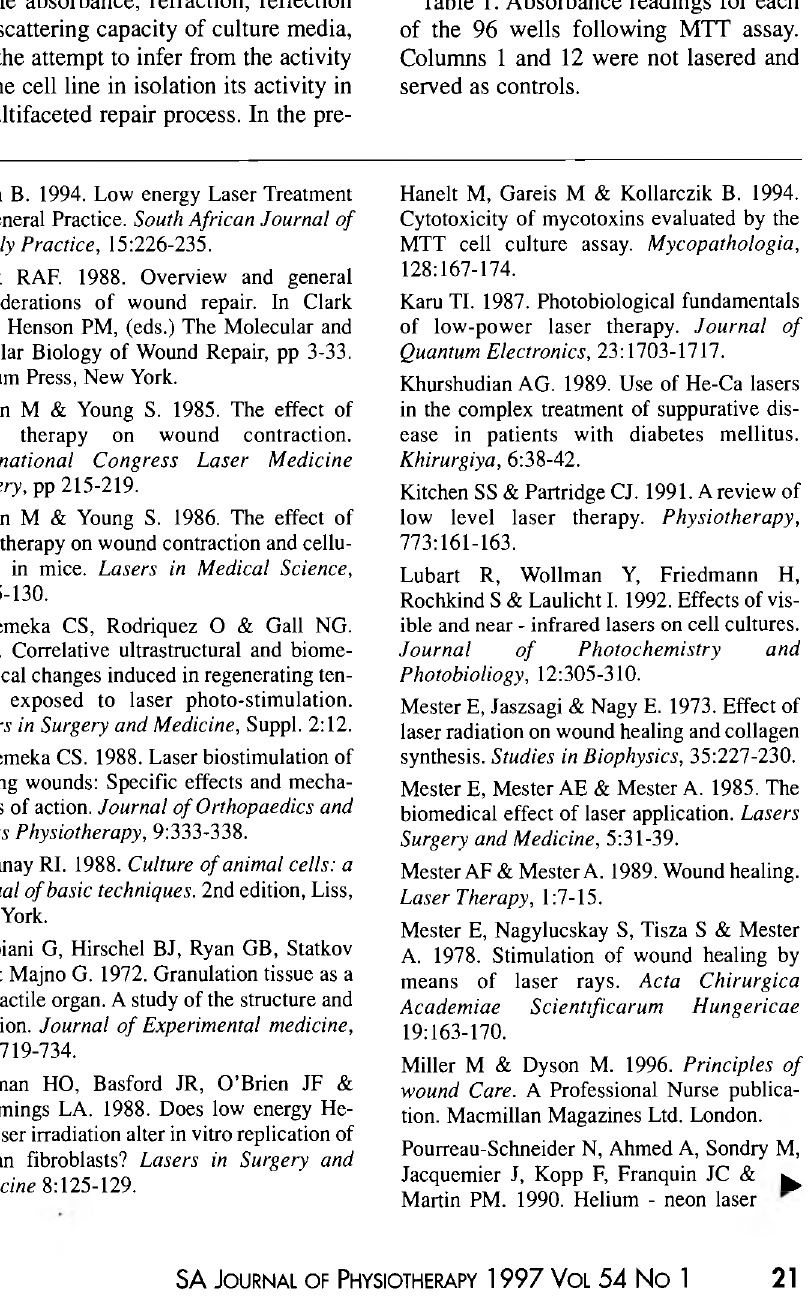
Table 1. Absorbance readings for each of the 96 wells following MTT assay. served as